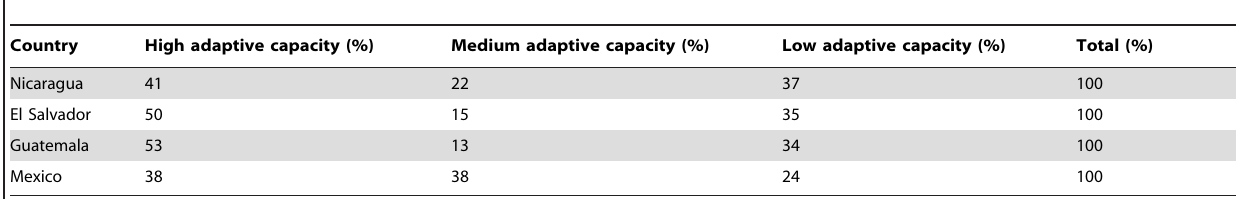
Country High adaptive capacity